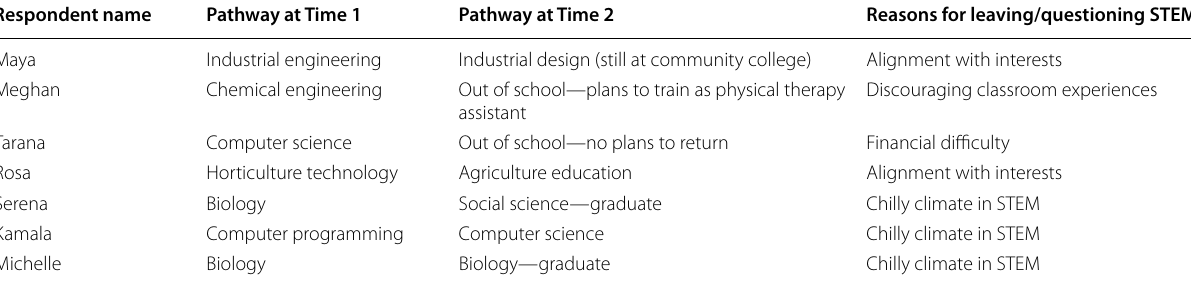
Table 2 Respondents’ educational goals at Interviews #1 and